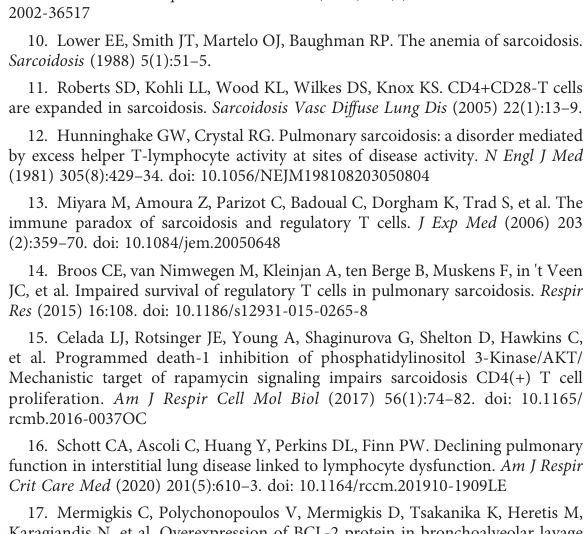
under-expressed genes in the blue (E) modules between cohorts. SUPPLEMENTARY FIGURE 5 Differential expression analysis in UIC STAR cohort. (A) Volcano plots demonstrating differentially expressed genes between lymphopenic and non-lymphopenic sarcoidosis cases based on clinical CD4+ T-cell grouping. (B) Consensus gene expression between ACCESS and UIC STAR cohorts was assessed by t-statistics determined for all genes in the blue and magenta